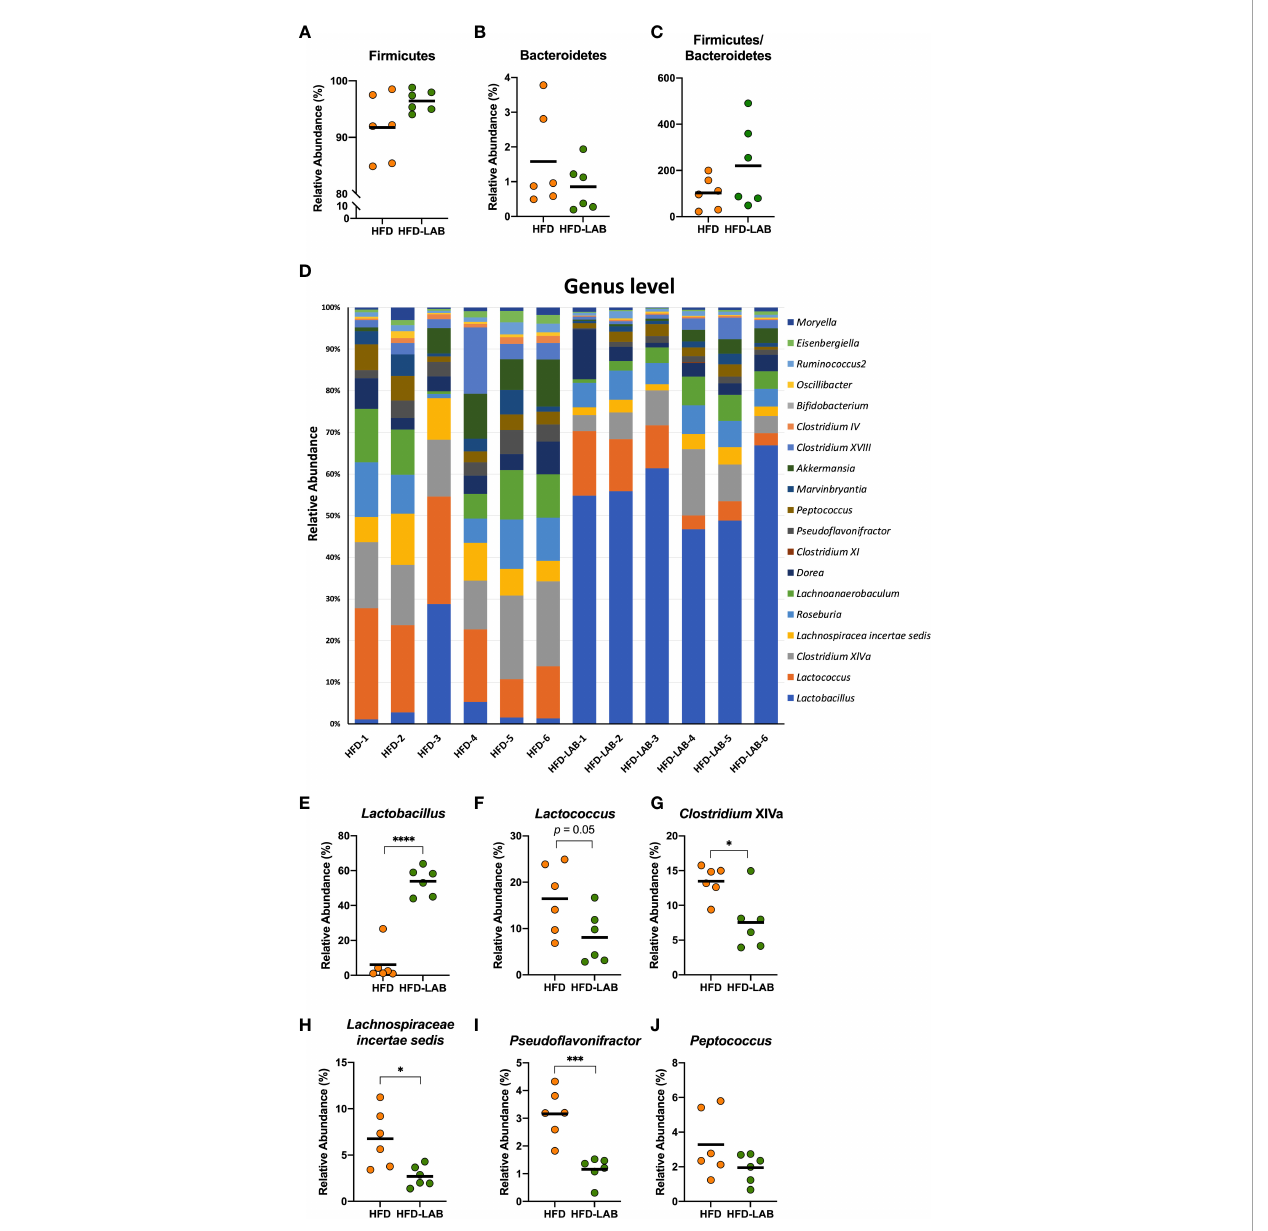
FIGURE 5 Oral administration of L. plantarum OLL2712 caused changes in the gut microbiota composition of mice. C57BL/6N male mice fed an HFD and treated with OLL2712 were compared with those fed an HFD and treated with sterilized water. The cecal contents of the mice were isolated, and the gut microbiota was investigated with next-generation sequencing applications. At the phylum level, the relative abundance of Firmicutes (A) and Bacteroidetes (B) and the ratio of the two (C) were calculated. At the genus level, the composition of the gut microbiota of each mouse was analysed and compared (D) . The relative abundance of Lactobacillus (E) , Lactococcus (F) , Clostridium XIVa (G) , Lachnospiraceae incertae sedis (H) , Pseudo fl avonifractor (I) , and Peptococcus (J) in mice treated with OLL2712 were calculated and compared with those treated with water. The results are representative of two independent experiments and are shown as the mean ± standard deviation (n = 6). * p <0.05; *** p <0.001; **** p <0.0001 (assessed using Student ’ s t -test). HFD, high-fat diet; LAB, lactic acid bacteria ( L. plantarum